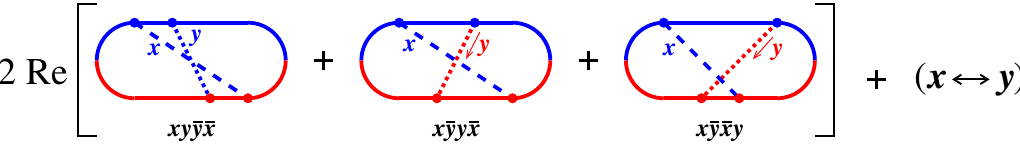
Figure 14 . The sum of diagrams that define the quantity A ( x, y ) in ref.